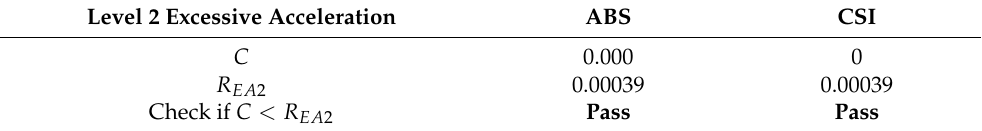
Table 18. Level 2 assessment of the excessive acceleration failure mode for C11 container ship.